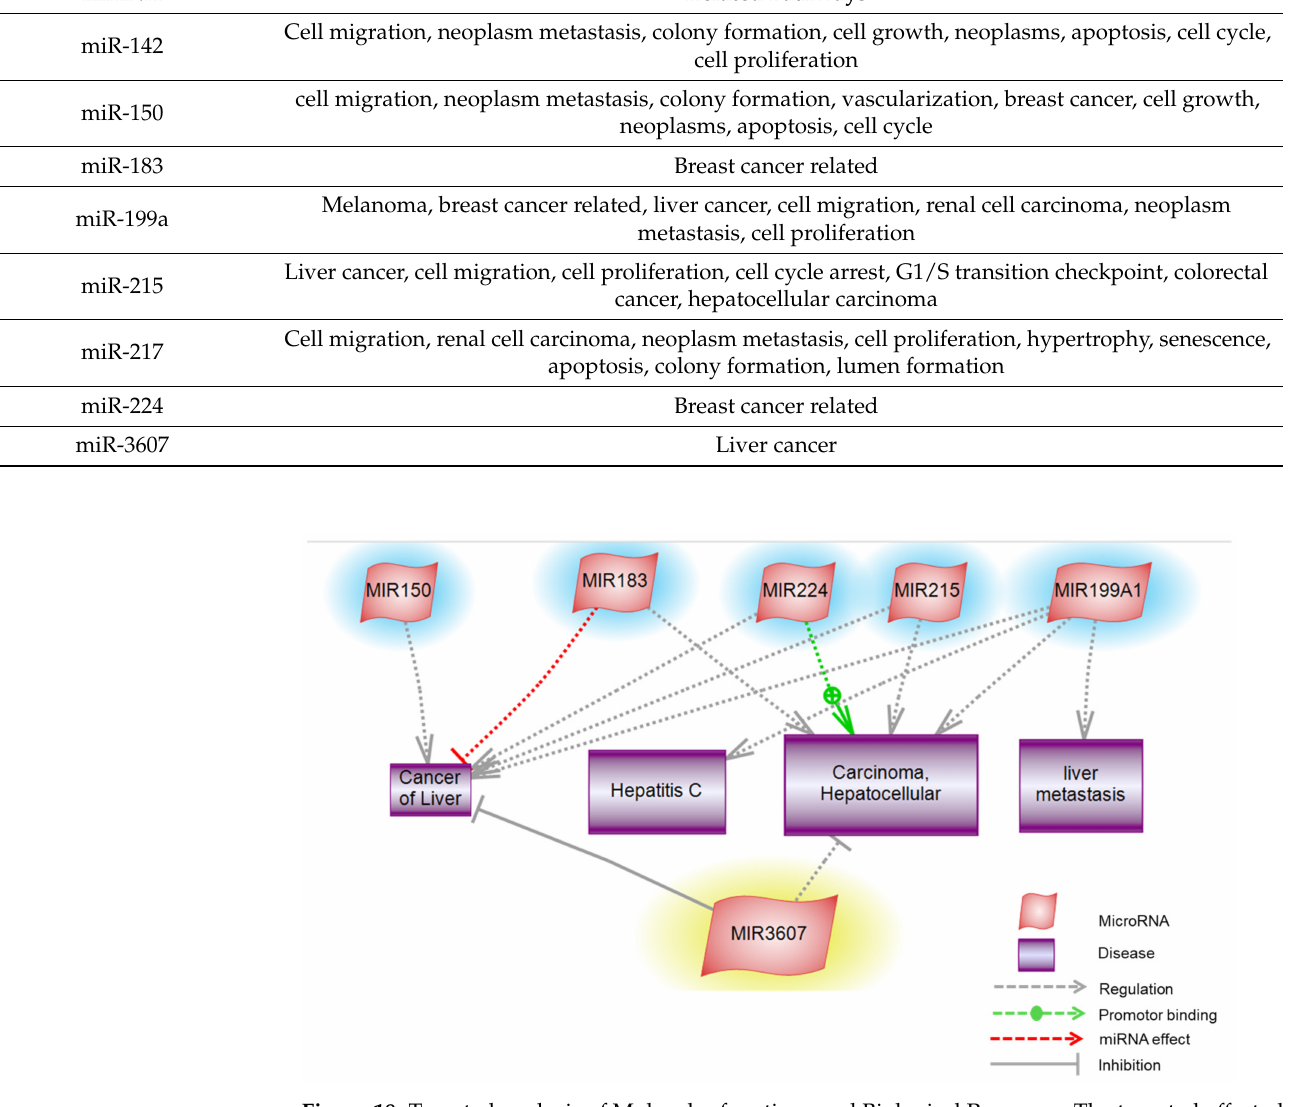
Figure 18. Targeted analysis of Molecular functions and Biological Processes. The targeted affected pathways involving: Hepatitis C, HCC, other types of liver cancer, and liver metastasis implicated in the miRNAs’ alteration (miR-150, miR-183, miR-199a, miR-215, miR-224, and